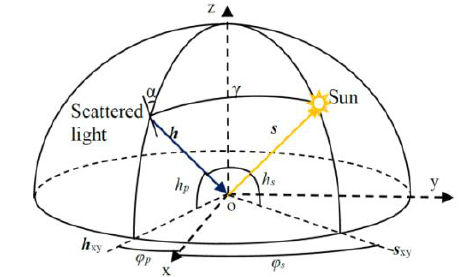
Figure 1. Geometric relationships of the solar vector and the skylight measured by sensor